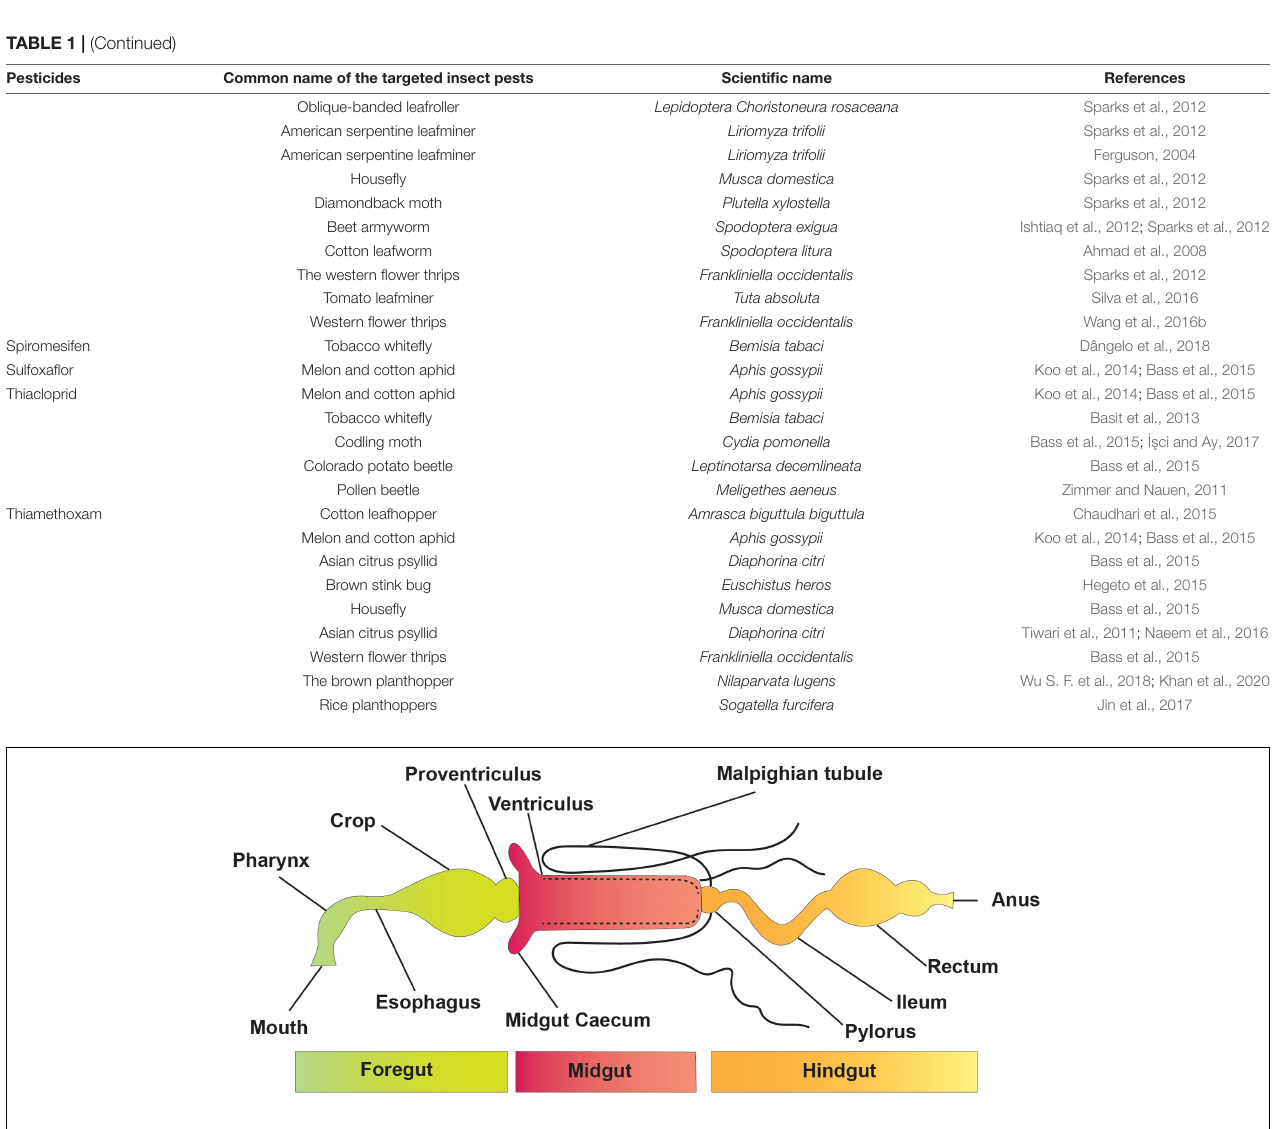
FIGURE 1 | Basic structure and divisions of the insect digestive